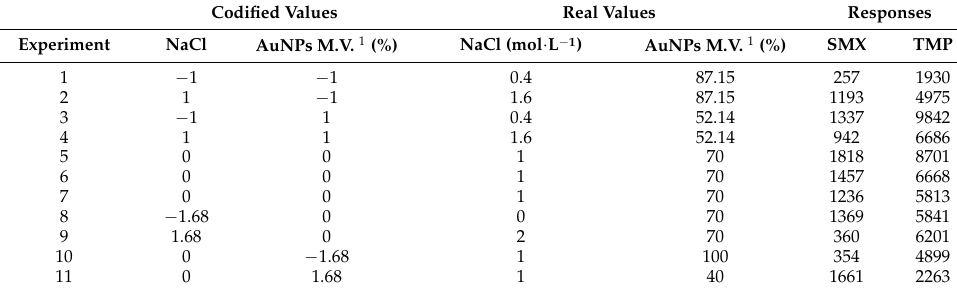
Table 1. Central composite experimental design and SERS intensity